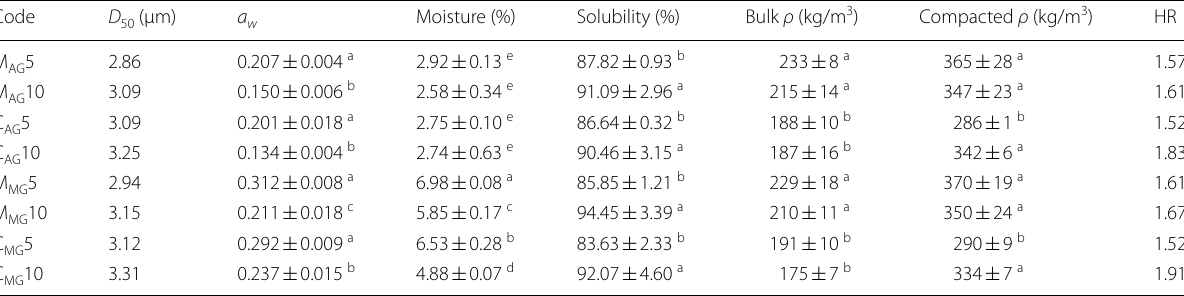
Table 2 Characterization of mamey and carrot carotenoid microcapsules